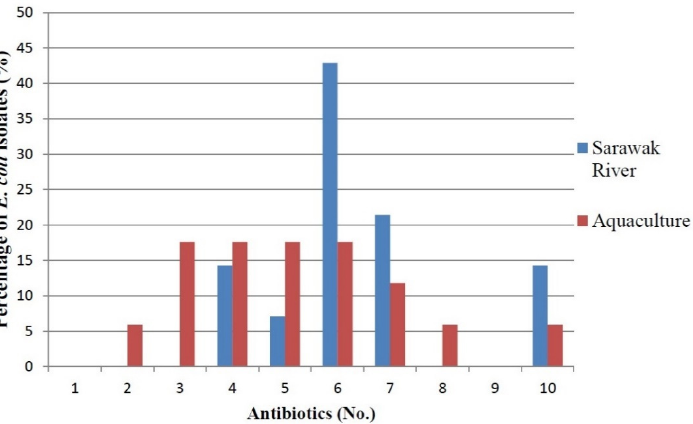
Figure 3. The percentage (%) of Escherichia coli isolated from aquaculture farms that showed Susceptible, Intermediate and Resistant against the 12 antibiotics tested.